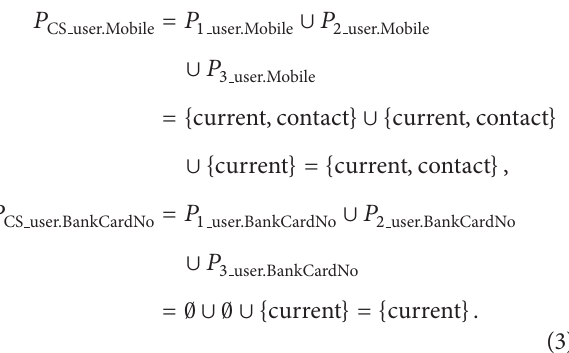
Policy Policy Policy 1 2 3 A